Question: Write a descriptive caption for this figure.
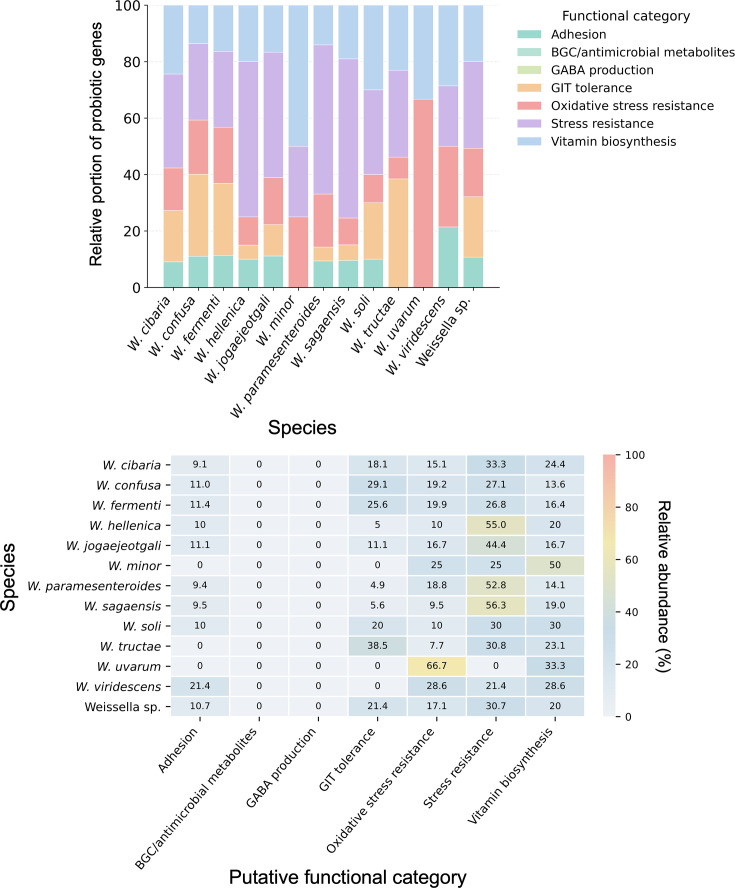
Answer: Distribution of putative probiotic-associated genetic potential across Weissella species. ( A ) Stacked bar plot showing the relative composition of putative probiotic-associated genetic categories, normalized to 100% within each species. ( B ) Heatmap showing the corresponding percentage contribution of each category across species. Functional categories include adhesion and colonization, BGC and antimicrobial metabolites, GABA production, GIT tolerance, oxidative stress resistance, general stress resistance, and vitamin biosynthesis.